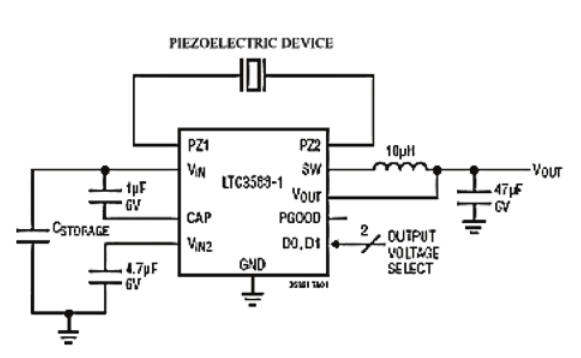
Fig. 7. Parallel capacitance vs. frequency of the prepared PZT Fig. 8. Piezoelectric transducer